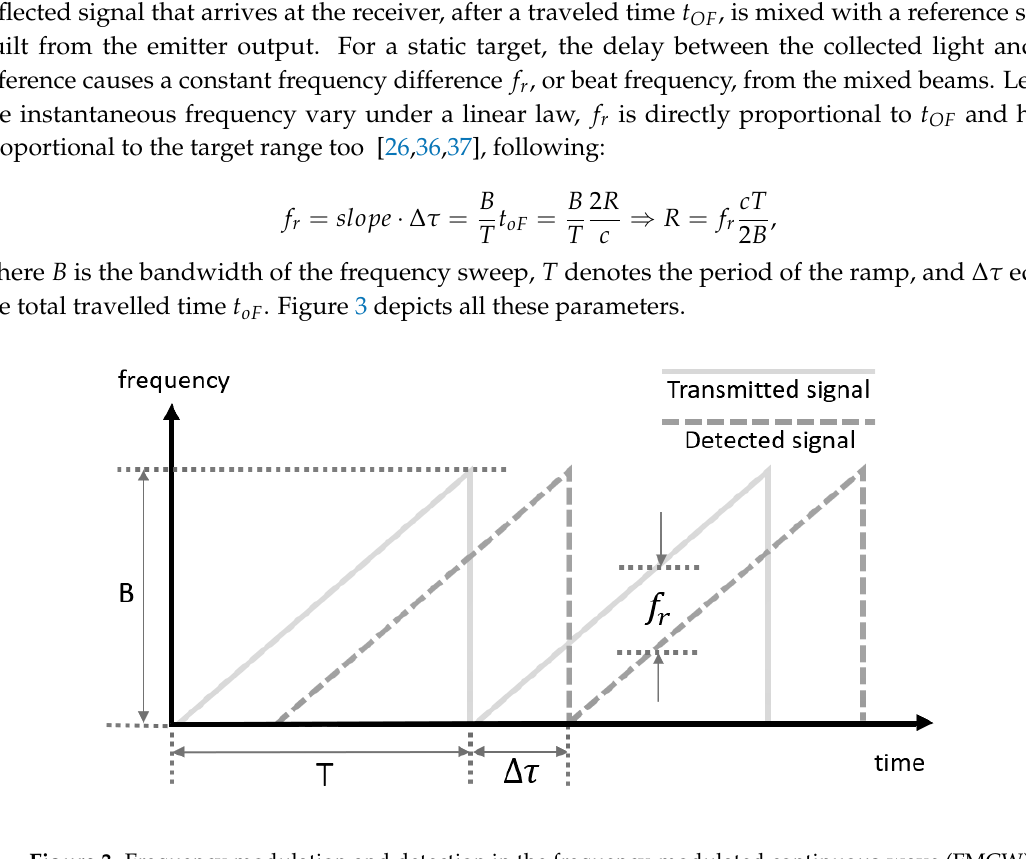
Figure 3. Frequency modulation and detection in the frequency-modulated continuous-wave (FMCW) method: main parameters